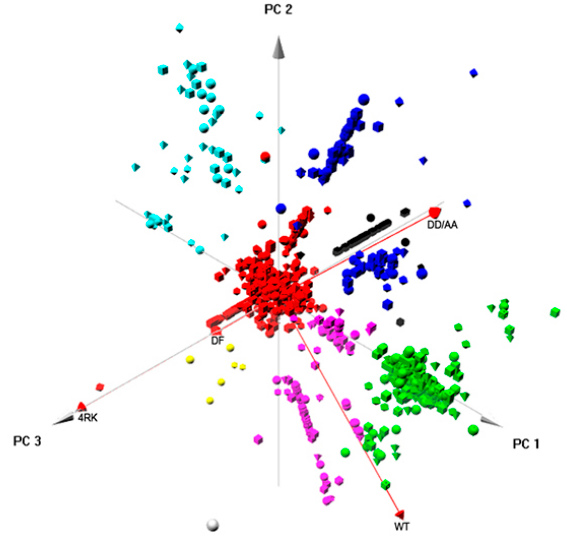
Figure 6. Component analysis for full-length CFTR variants. PCA was performed using the package “pca3d” from R programming [31]. Data corresponding to the combinations of the median of the amount of each protein immunoprecipitated with each CFTR variant calculated as described above were used for PCA analysis. The PCA scores corresponding to the three main components are plotted in a scatter plot in which the position along the axes show the PCA score of the protein. Clustering was performed using hierarchical agglomerative clustering through the standard R function “hclust” and using average linkage as a clustering method.